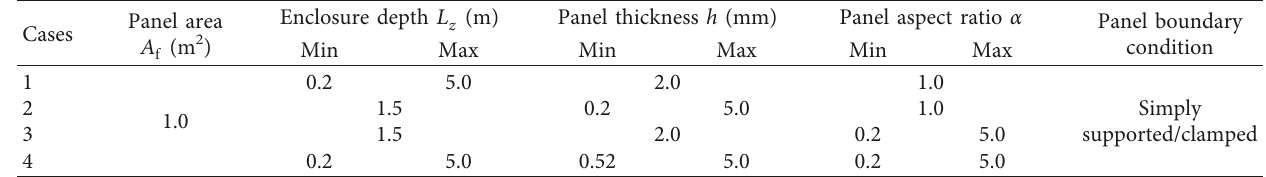
Table 1: Parameters’ range for case study.